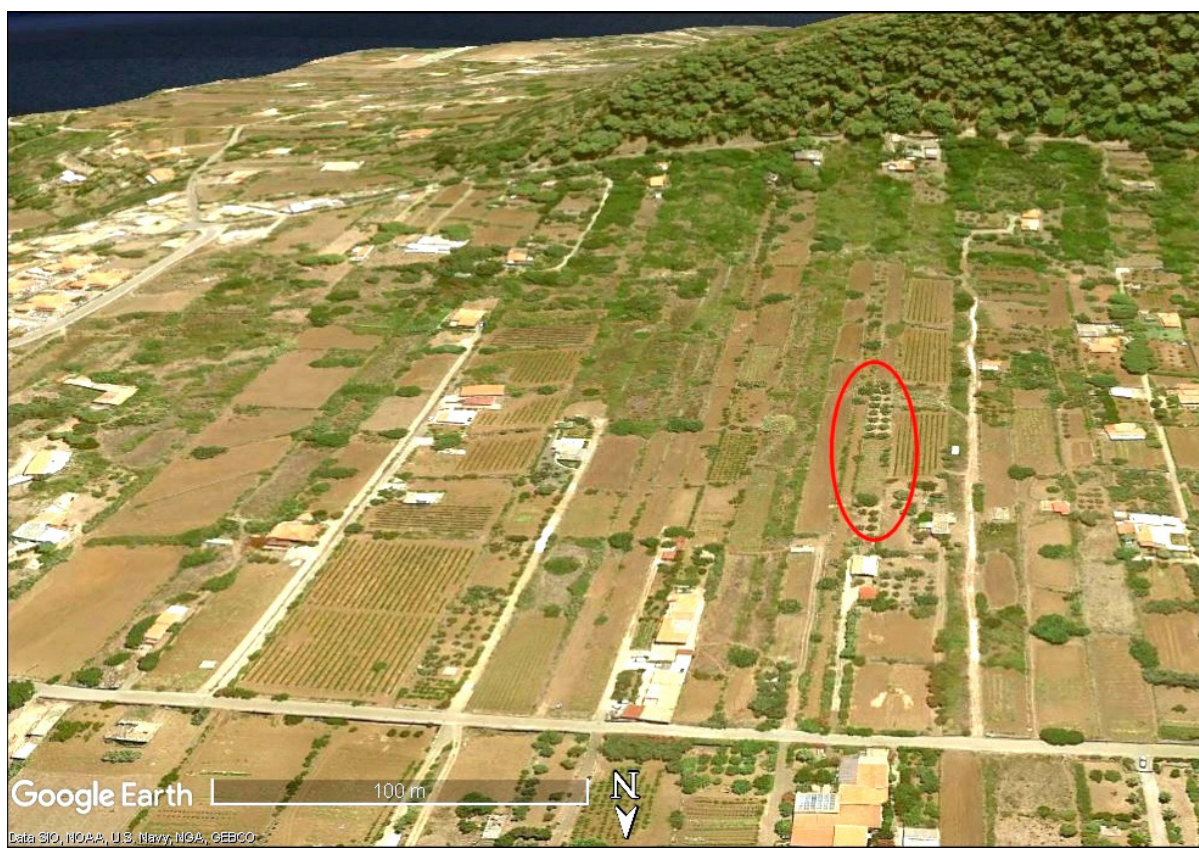
Figure 2: Aerial view of Casa dei Francesi area at Tramontana, Ustica. The red ellipse indicates the agricultural fields where abundant obsidian fragments were collected (modified from Google